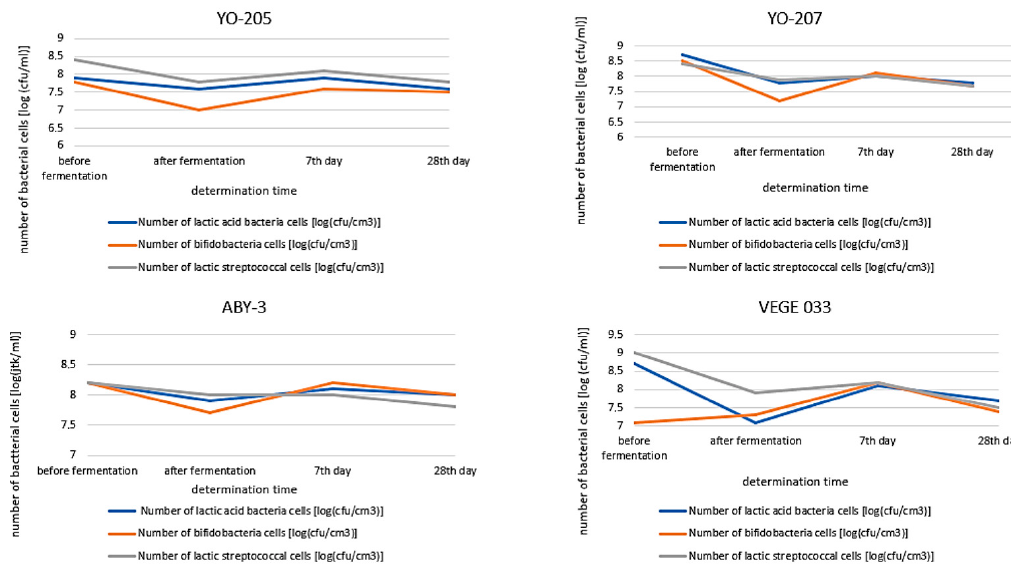
Figure 2. Population of lactic acid bacteria and bifidobacteria in buckwheat beverages fermented by starter cultures (mean values and standard deviations, n =